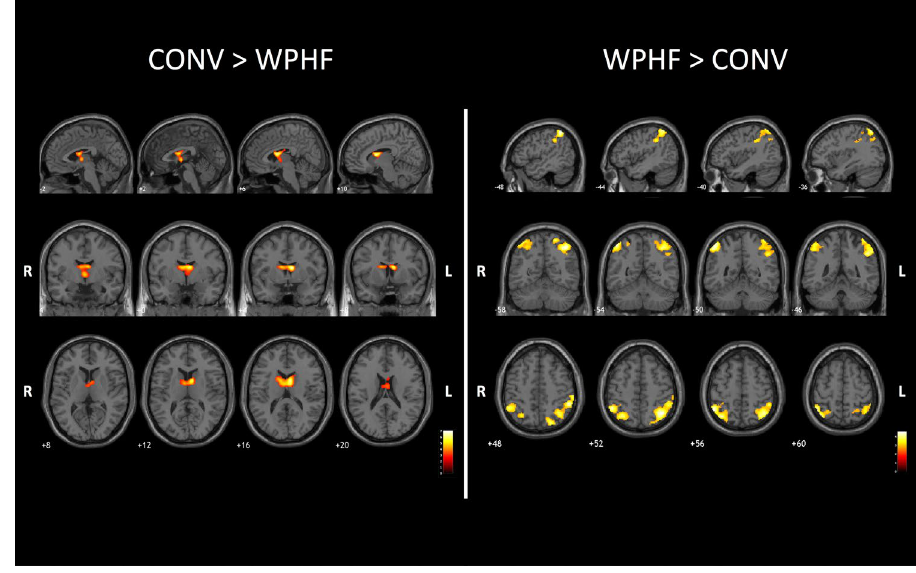
Figure 5. Whole brain contrast maps ( p < 0.005; k = 20; FDR corrected at cluster level p < 0.05) between the two NMES protocols (top, sagittal view; middle, coronal view; bottom, axial view). Statistical maps were coregistered with the SPM-MNI single subject T 1 images. The color scale represents the T values. R: right hemisphere; L: left